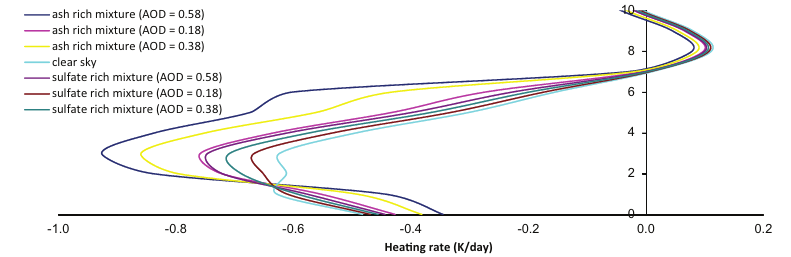
Fig. 10. The effect of aerosol composition and AOD(550nm) of a thin plume ( ∼ 2.5–7km) on LW cooling rate. Table 3. Shortwave (SW) and total DARFE for a thick ( ∼ 3–20km) plume in Wm − 2 AOD − 1 . DARFE was calculated for a range of AOD between 1 and 3.